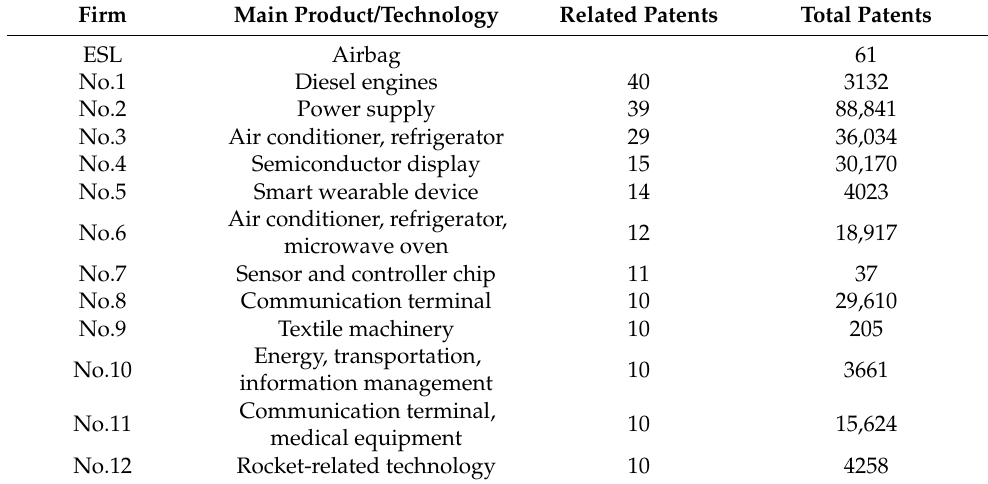
Table 2. List of related